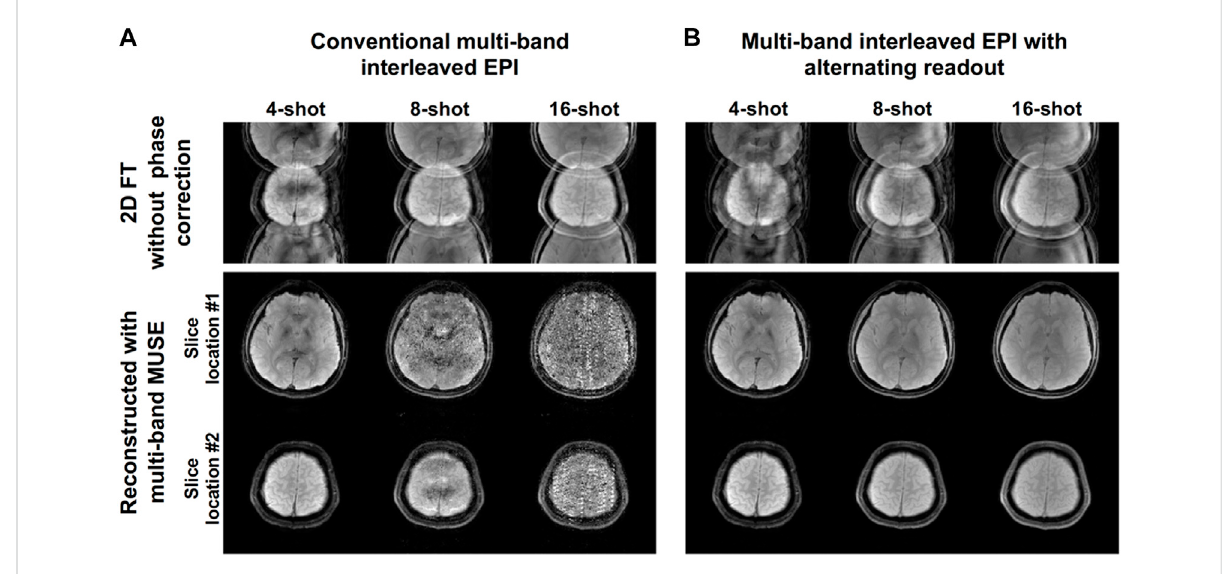
FIGURE 6 Two-dimensional multi-band multi-shot GE-EPI images produced from MUSE reconstruction of the data acquired using either (A) conventional interleaved EPI or (B) interleaved EPI with alternating readout. Only interleaved EPI with alternating readout and MUSE reconstruction successfully performed 2D Nyquist ghost correction for the 2-band GE-EPI acquired with different number of shots (i.e., 4, 8, and 16 shots). This experiment demonstrated that the proposed method can simultaneously perform data reconstruction of multi-band multi-shot GE-EPI (i.e., separation of two overlapped slices) and 2D Nyquist ghost correction with considering slice-dependent phase